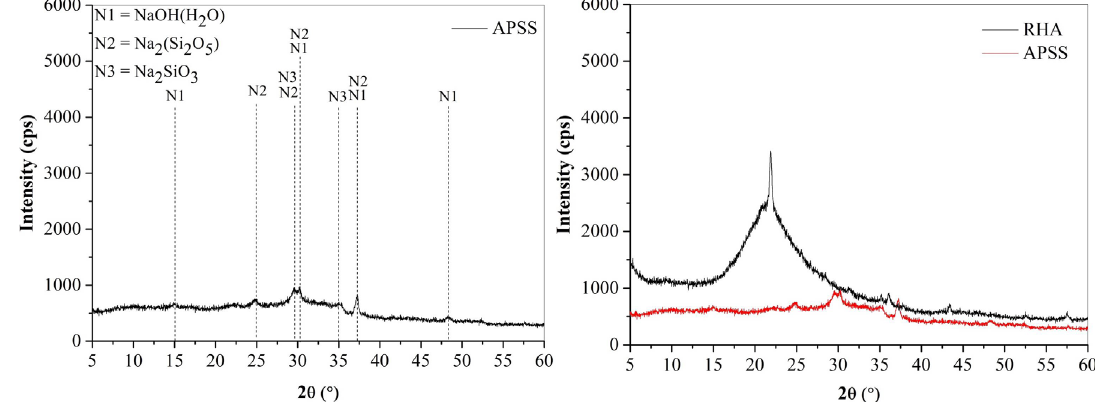
Figure 5. XRD results of APSS (a) and XRD of RHA and APSS (b).